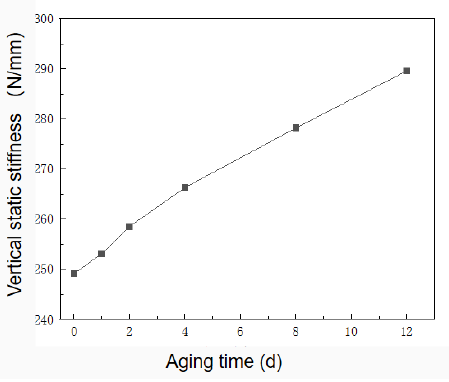
Figure 5. Variation curve of vertical static stiffness of air spring with aging